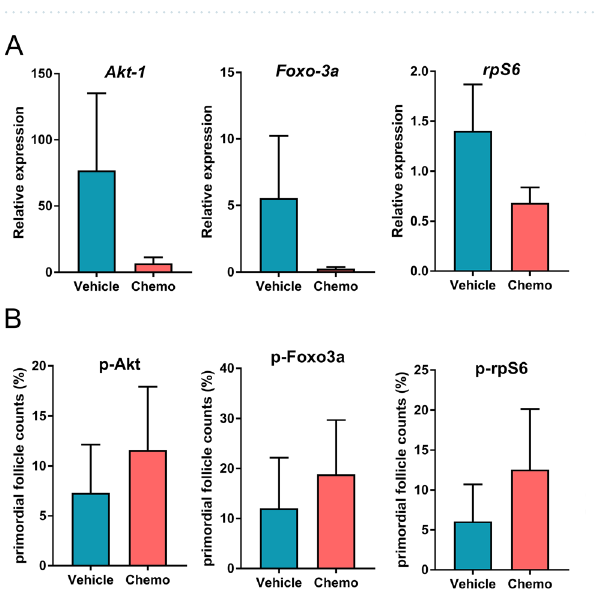
Figure 3. RNA-Sequencing results indicating lack of activation of the PI3K/PTEN/Akt pathway in vivo 12 h after chemotherapy exposure. Significant decrease in the expression of ( A ) PECAM1 (p = 2.13E−09), ( B ) IKBKE (p = 0.001) and ( C ) ANGPT1 (p = 0.03) that are reported to be anti-apoptotic with pro effects on the PI3K/ PTEN/Akt pathway. In cyclophosphamide-treated samples, there was a trend towards a decline in the expression of PI3K/PTEN/Akt pathway member Akt-1 (p = 0.19) ( D ) while no changes in the expressions of the Foxo3a (p = 0.8) ( E ) or rpS6 (p = 0.36) ( F ) were observed. R software was used to generate the image.